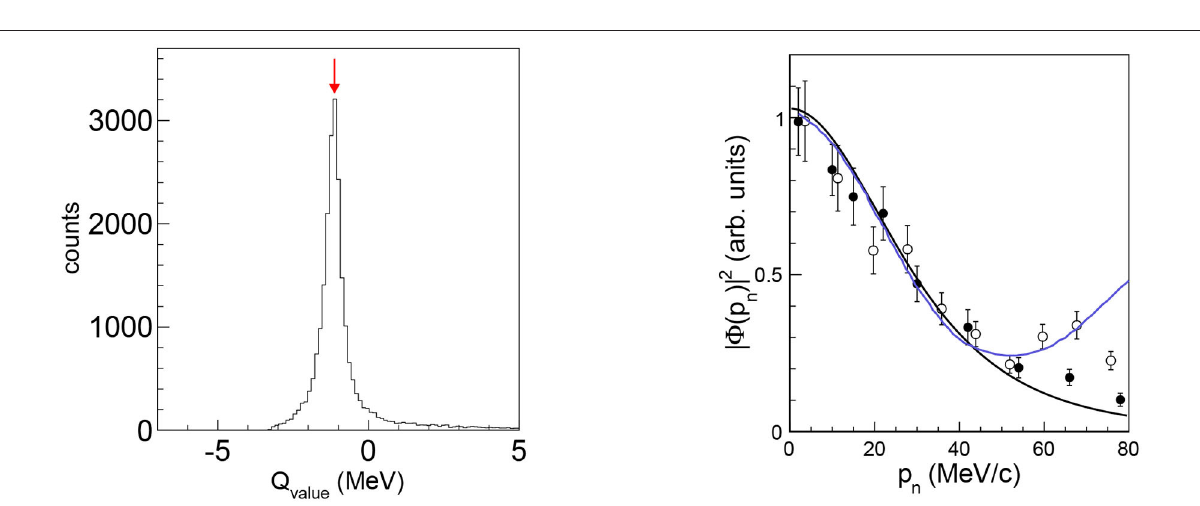
FIGURE 3 | (Left) Experimental Q -value spectrum for LNS experiment. A single peak shows up, centered at about − 1.0 MeV, corresponding to the 2 H( 17 O, α 14 N)n channel. The red arrow corresponds to the theoretical Q-value, Q th = − 1.033 MeV. Similar spectrum was obtained for the ND experimental data. (Right) Experimental momentum distribution (full dots for LNS experiment and empty dots for NSL experiments) compared with the theoretical one given by the squared Hulthén wave function in momentum space (black line) and the one given in terms of a DWBA calculation performed via the FRESCO code (blue line). The error bars include only statistical